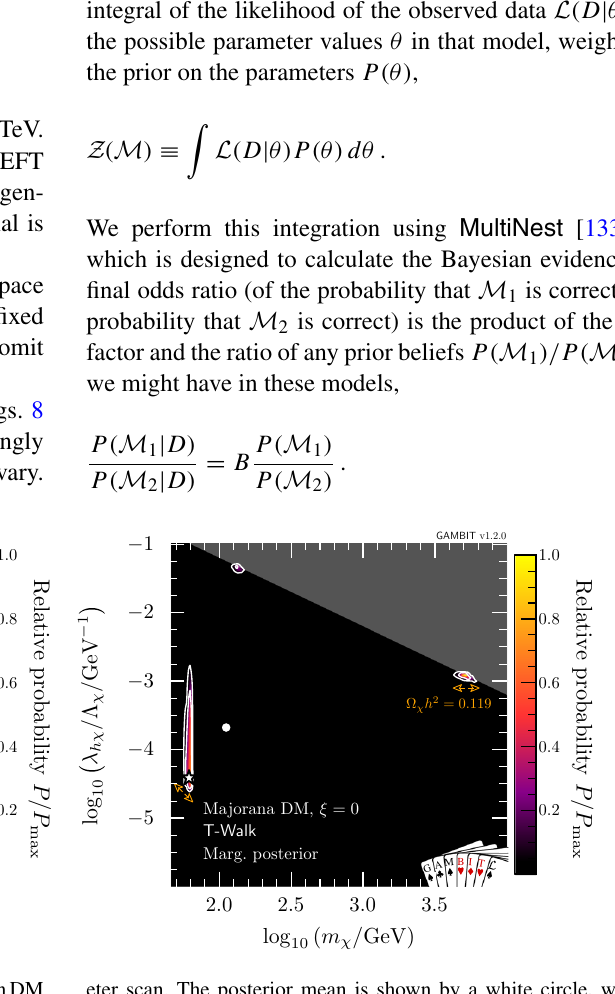
eter scan. The posterior mean is shown by a white circle, while the maximum likelihood point is shown as a white star. The edges of the preferred parameter space along which the model reproduces the entire observed relic density are indicated with orange